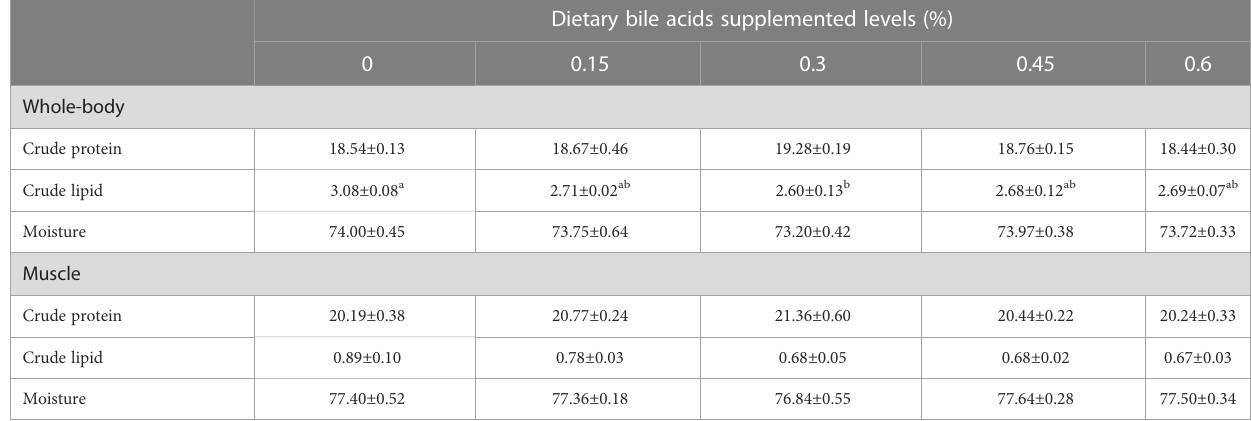
TABLE 4 Whole-body and muscle composition of coral trout fed the experimental diets for 10